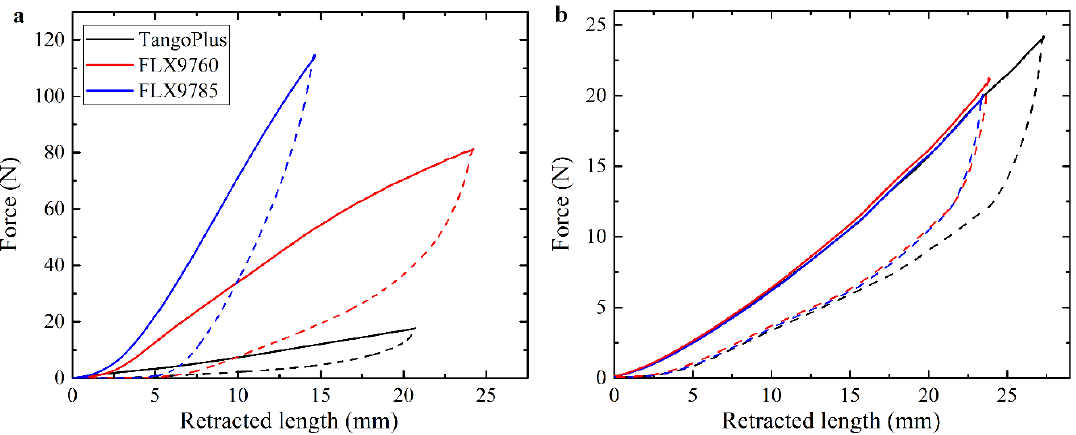
Figure 3. Force-retraction curves, obtained for homogeneous actuator made of different base materials ( a ). Three consecutive actuations for the homogeneous TangoPlus actuator with central position of the cable channel and 50 g dead weight attached to the free end ( b ). Solid curves represent loading, dashed curves are obtained during unloading.